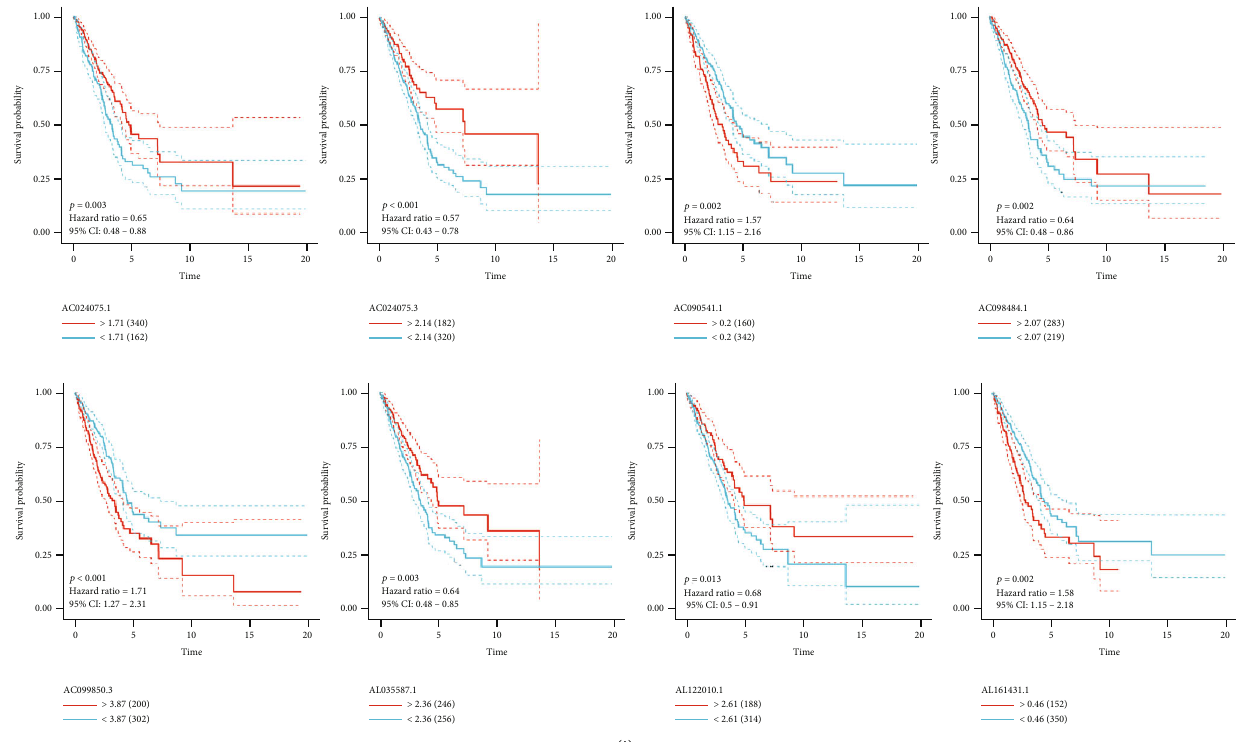
Figure 3: The excellent e ffi cacy of the cuproptosis-relevant lncRNA signature in predicting LUAD prognosis. (a, b) K-M curves of OS between low- and high-risk subsets and ROC curves at 1- and 3-year OS, together with 5-year OS. (C, D) K-M curves of DFS between subsets, and ROC curves at 1- and 3-year DFS, together with 5-year DFS. (e, f) K-M curves of DSS between subsets and ROC curves at 1- and 3-year DSS, together with 5-year DSS. (h, h) K-M curves of PFS between subsets and ROC curves at 1- and 3-year PFS, together with 5-year PFS. (i) K-M curves of OS between two subsets strati fi ed by the median values of expression of prognostic cuproptosis- relevant